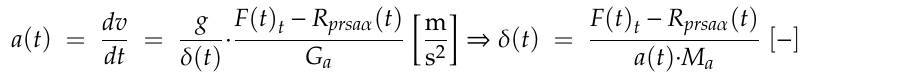
Figure 9. Variation of the mass moment of inertia coefficient depending on the speed of the vehicle.